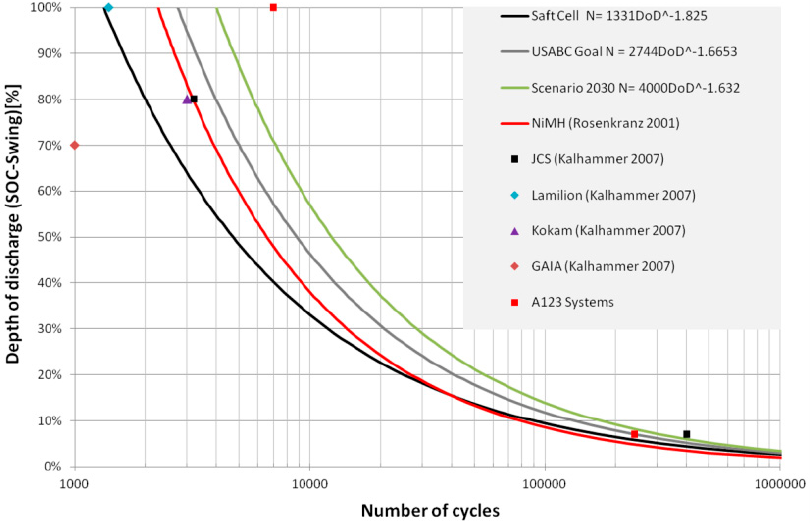
Figure 8. Battery cycle life as a function of the depth of discharge [32–36].